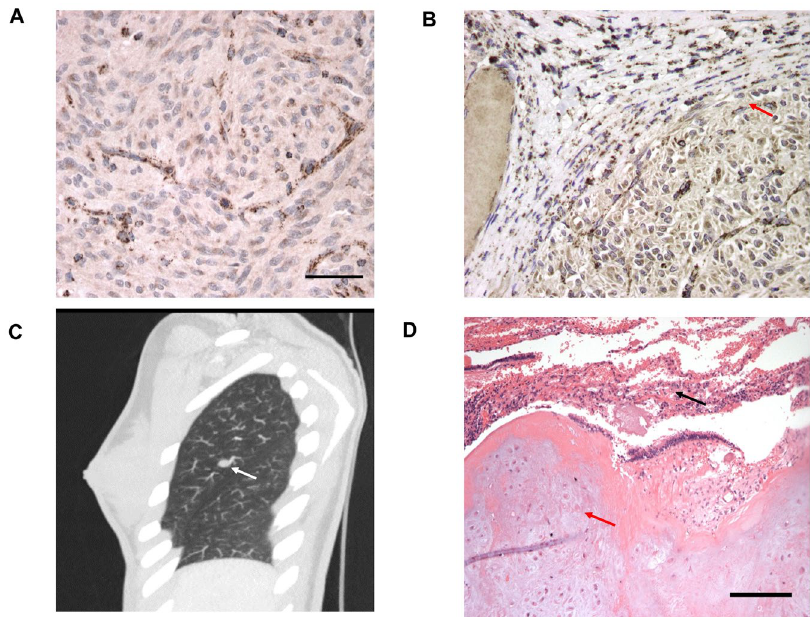
Figure 3. Figure ( A ) and ( B ) shows loss of SDHB protein expression on immunohistochemical analysis of the primary wtGIST tumour in case #001 and #003 respectively. In Figure ( B ) SDHB expression is preserved in adjacent normal tissue as highlighted by the red arrow. Figure ( C ) shows a pulmonary chondroma in case #021 as demonstrated by the white arrow and Figure ( D ) demonstrates the histology of a pulmonary chondroma from case #004, with evidence of normal collapsed lung tissue illustrated by the black arrow and chondrocytes in the tumor marked by the red